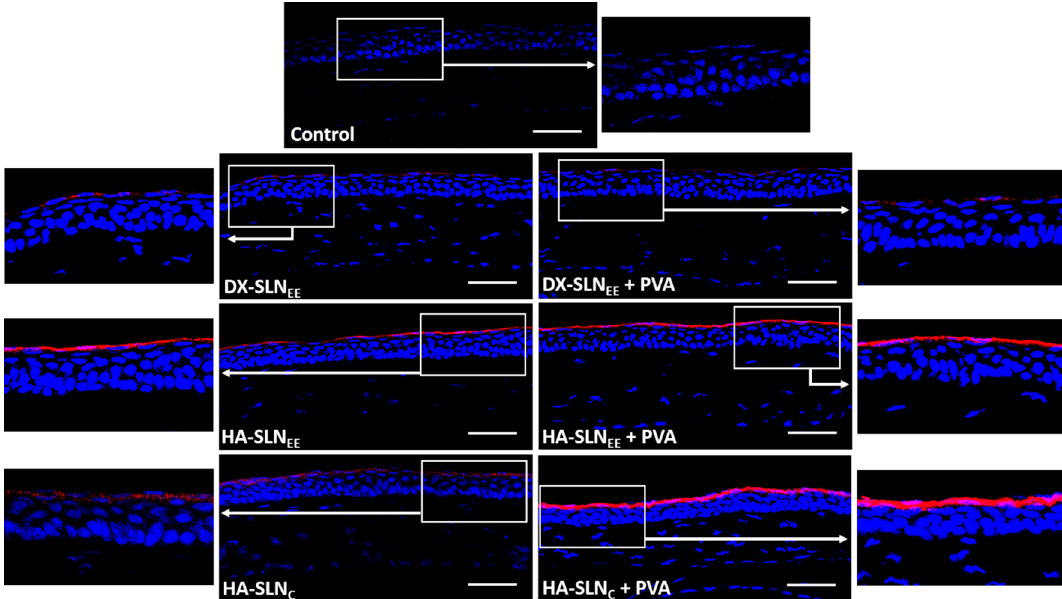
Figure 5. Localization of the formulations on the cornea of wild type mice (20 × ), 2 h after the instillation of the last dose. Blue: nuclei stained with DAPI. Red: vectors with IR780 iodide labelled SLNs. Scale bar: 50 µ m. DX: dextran; SLN: solid lipid nanoparticle; PVA: polyvinyl alcohol; HA: hyaluronic acid.